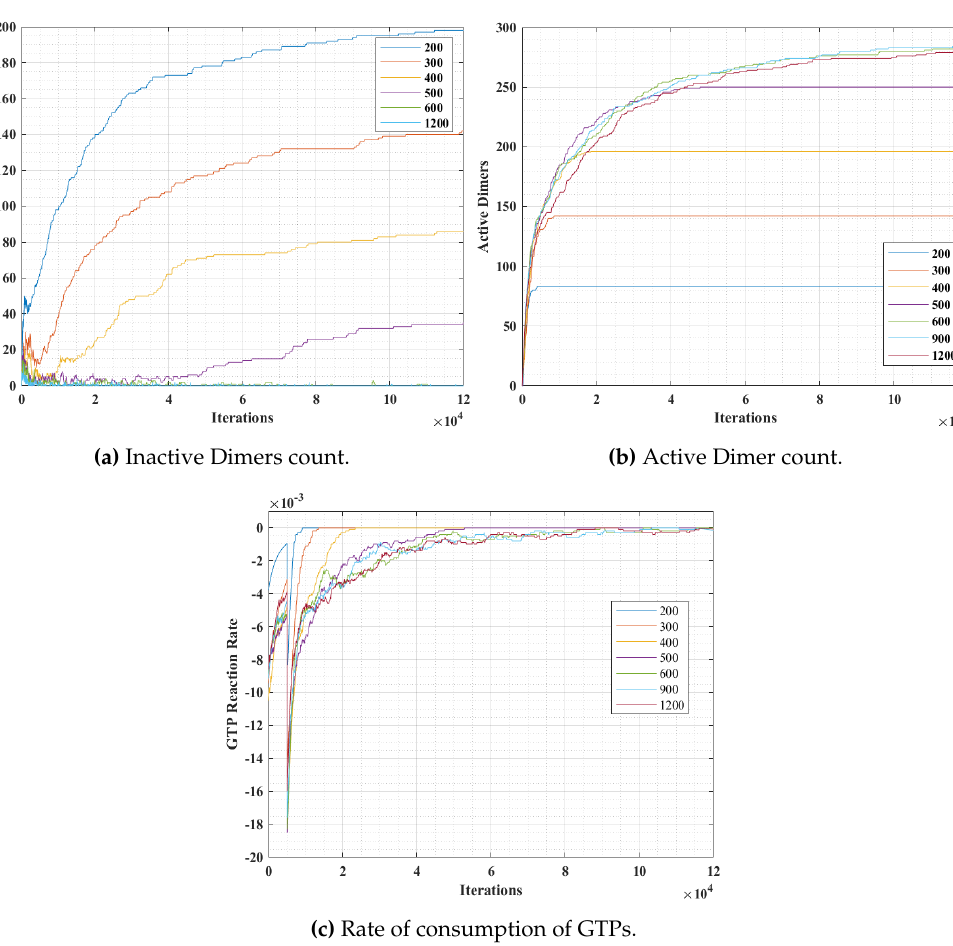
Figure 11. Snapshots of simulation—2 showing formation of protofilaments from tubulins. The simulation was run for 300 each of α and β tubulins, 600 GTPs, P GTP = 1 and 120,000 iterations and with no extended rules. Long chain protofilaments can be observed in the end.